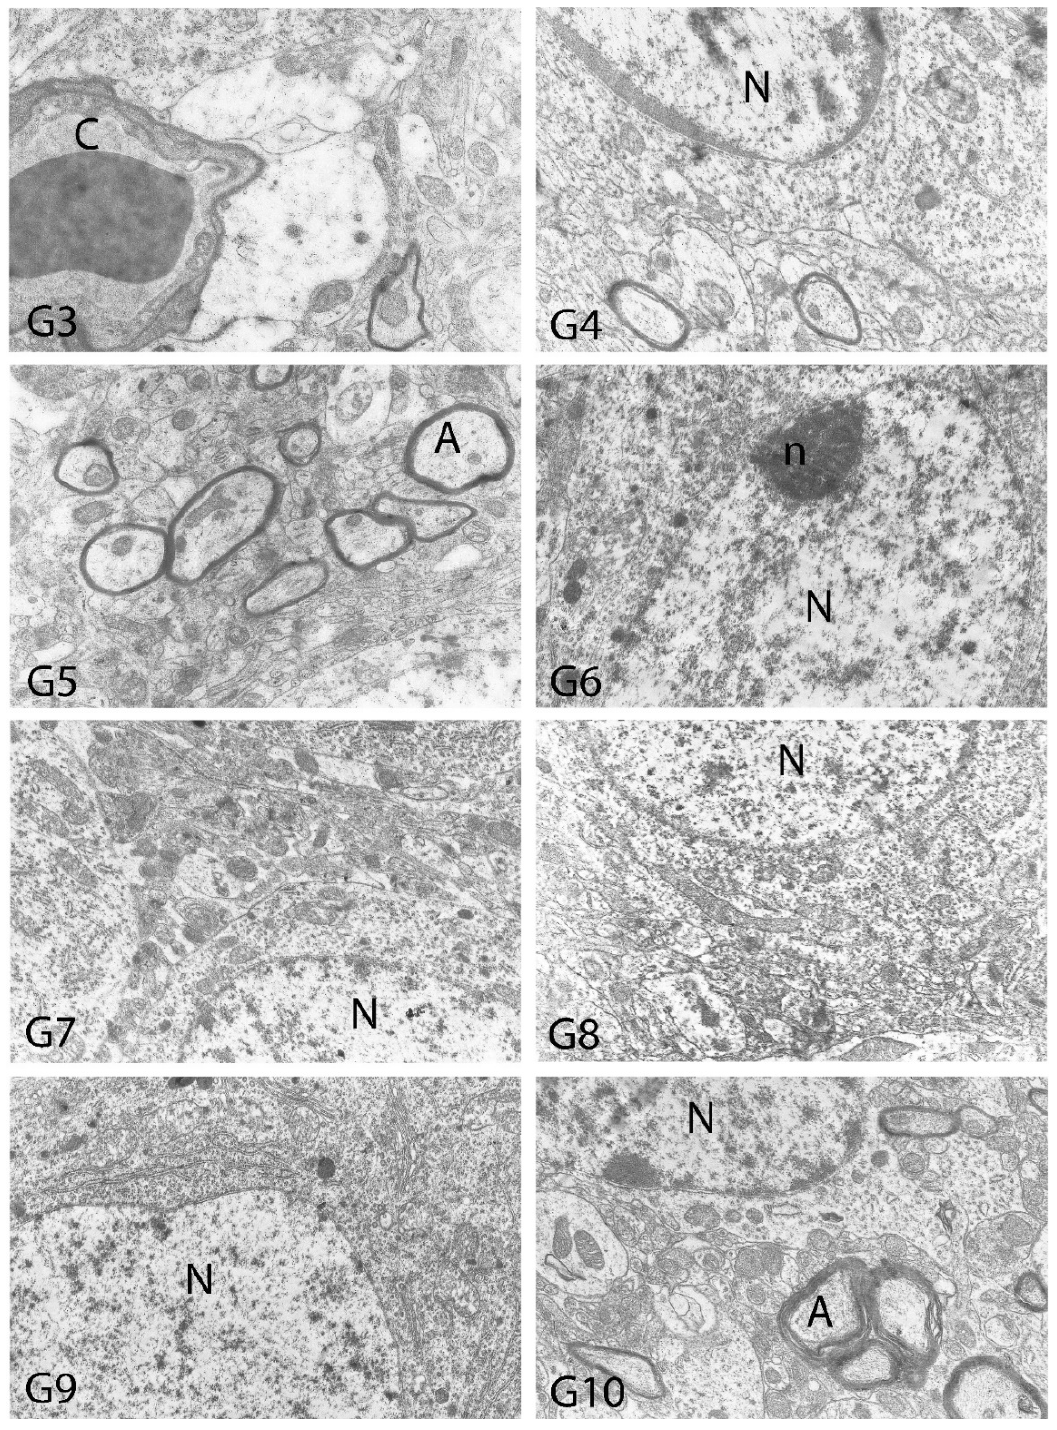
Figure 15. Electron micrographs of rat hippocampi from Groups 3 to 10 (G3–G10). N, nucleus; n, nucleolus; A, axon; C, capillary. Group definitions are as in Figure 9.